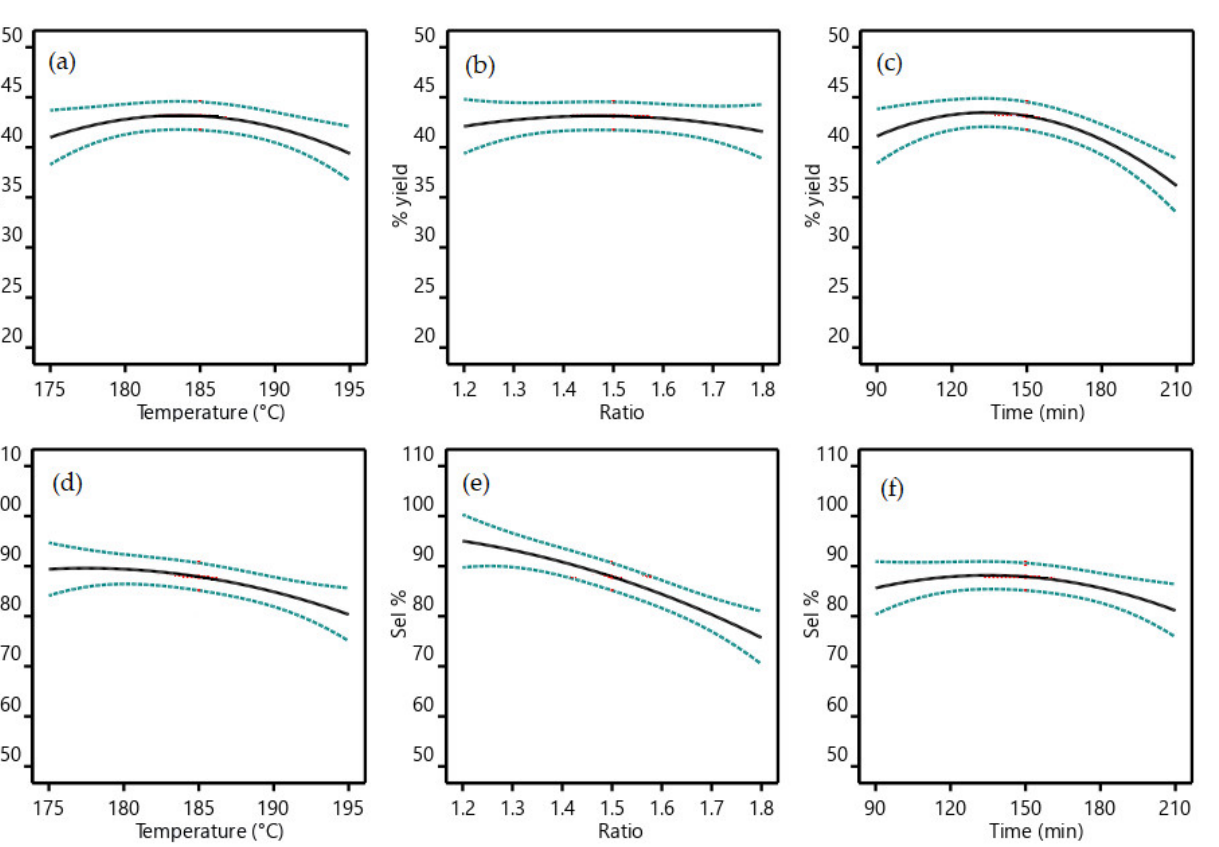
Figure 3. All factors graphs. ( a ) GC yield% vs. temperature, ( b ) GC yield% vs. urea/Gly MR, ( c ) GC yield% vs. recirculation time, ( d ) GC selectivity% vs. temperature, ( e ) GC selectivity% vs. urea/Gly ratio and ( f ) GC selectivity% vs. recirculation time. Dashed blue lines refers to minimum and maximum values of the data set. Continuous black lines refers to the mean values. The simultaneous influence of two independent variables on each physical property is of particular value. Figure 4 shows some “two factors response surfaces”, which put into evidence the dependency of GC yield% (left of Figure 4) from time–temperature or urea:Gly MR–time couples. On the right of the same figure, the influence of time–temperature or ratio–temperature couples on GC selectivity% are